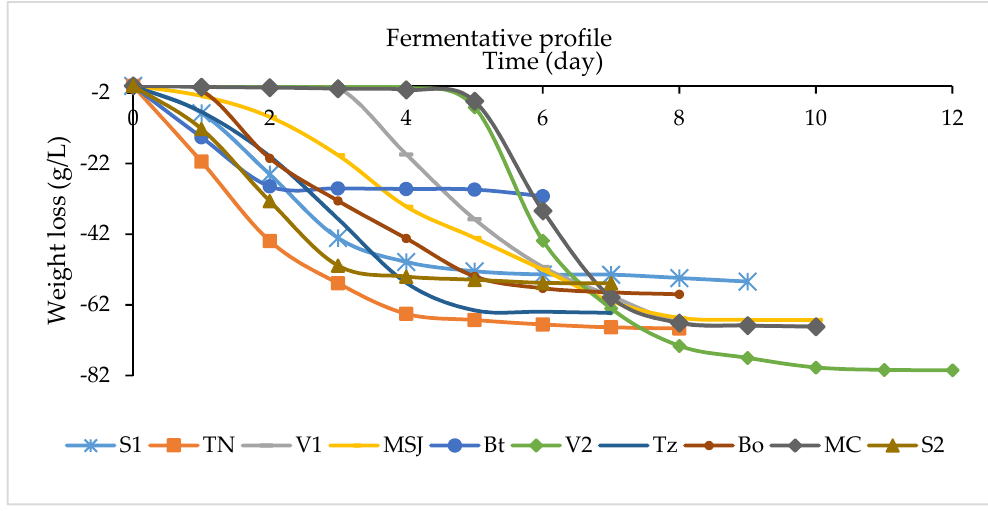
Figure 2. Fermentative profile ( S1 —Sercial 1 (Seixal); TN —Tinta Negra; V1 —Verdelho 1 (São Vicente); MSJ —Malvasia de São Jorge; Bt —Bastardo; V2 —Verdelho 2 (Prazeres); Tz —Terrantez;